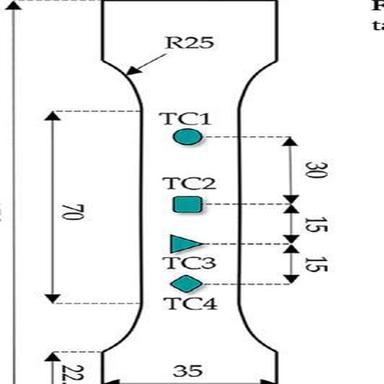
Gleeble 3180 test chamber with the detailed positioning of the 4 thermocouples.